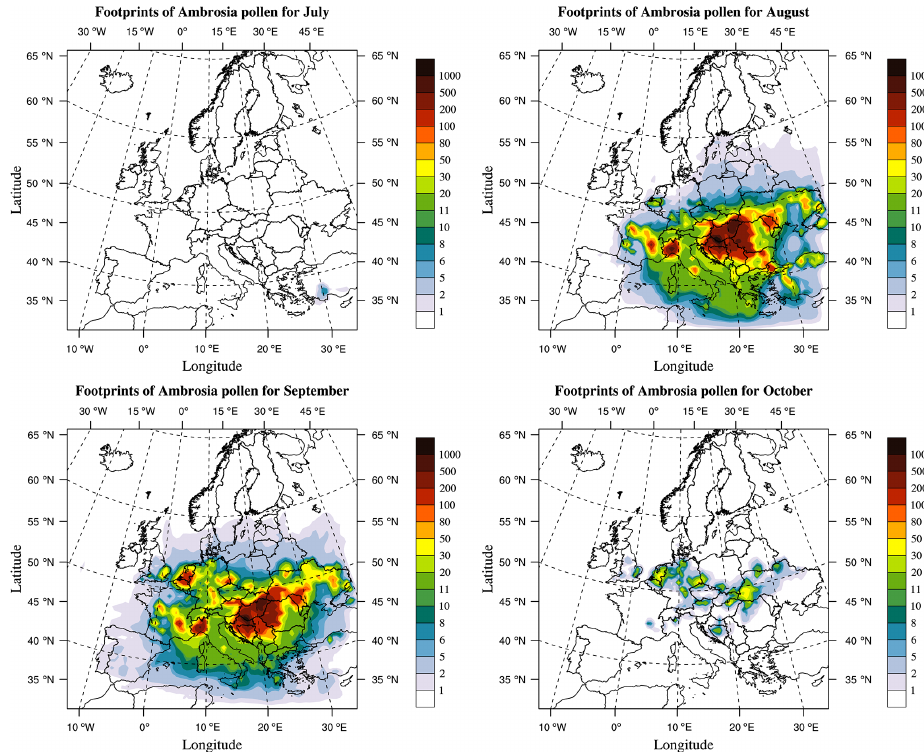
Figure 10. Footprints of ragweed pollen at the surface in each month during pollen season, average from 2000–2010, obtained by selecting the maximum from daily averaged concentrations in each month.